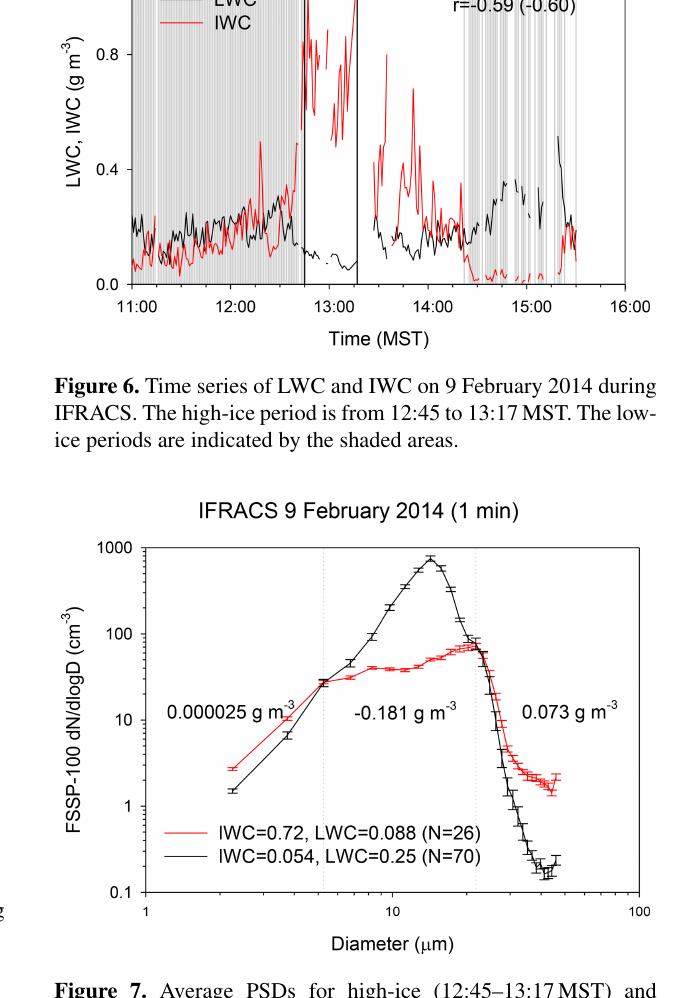
Figure 7. Average PSDs for high-ice (12:45–13:17MST) and low-ice ( < 12:45 or > 13:17MST and LWC / IWC > 2) periods in Fig. 6. The values in the middle of the plot are the differences be- tween the high (red) and low (black) cumulative LWC in the three sections of the distributions defined by the vertical dotted lines. The error bars are standard